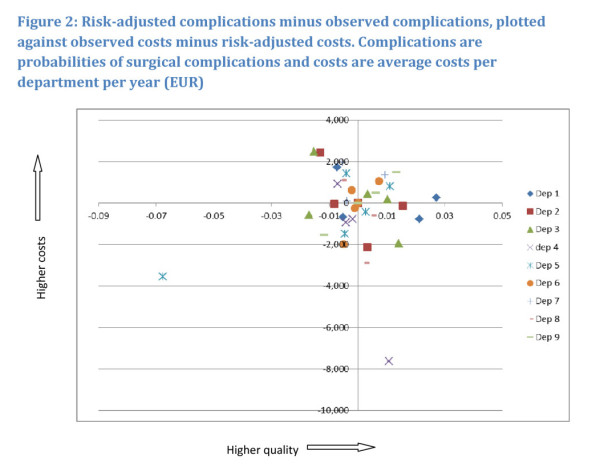
Risk-adjusted complications minus observed complications, plotted against
observed costs minus risk-adjusted costs. Complications are
probabilities of surgical complications and costs are average costs per
department per year (EUR).